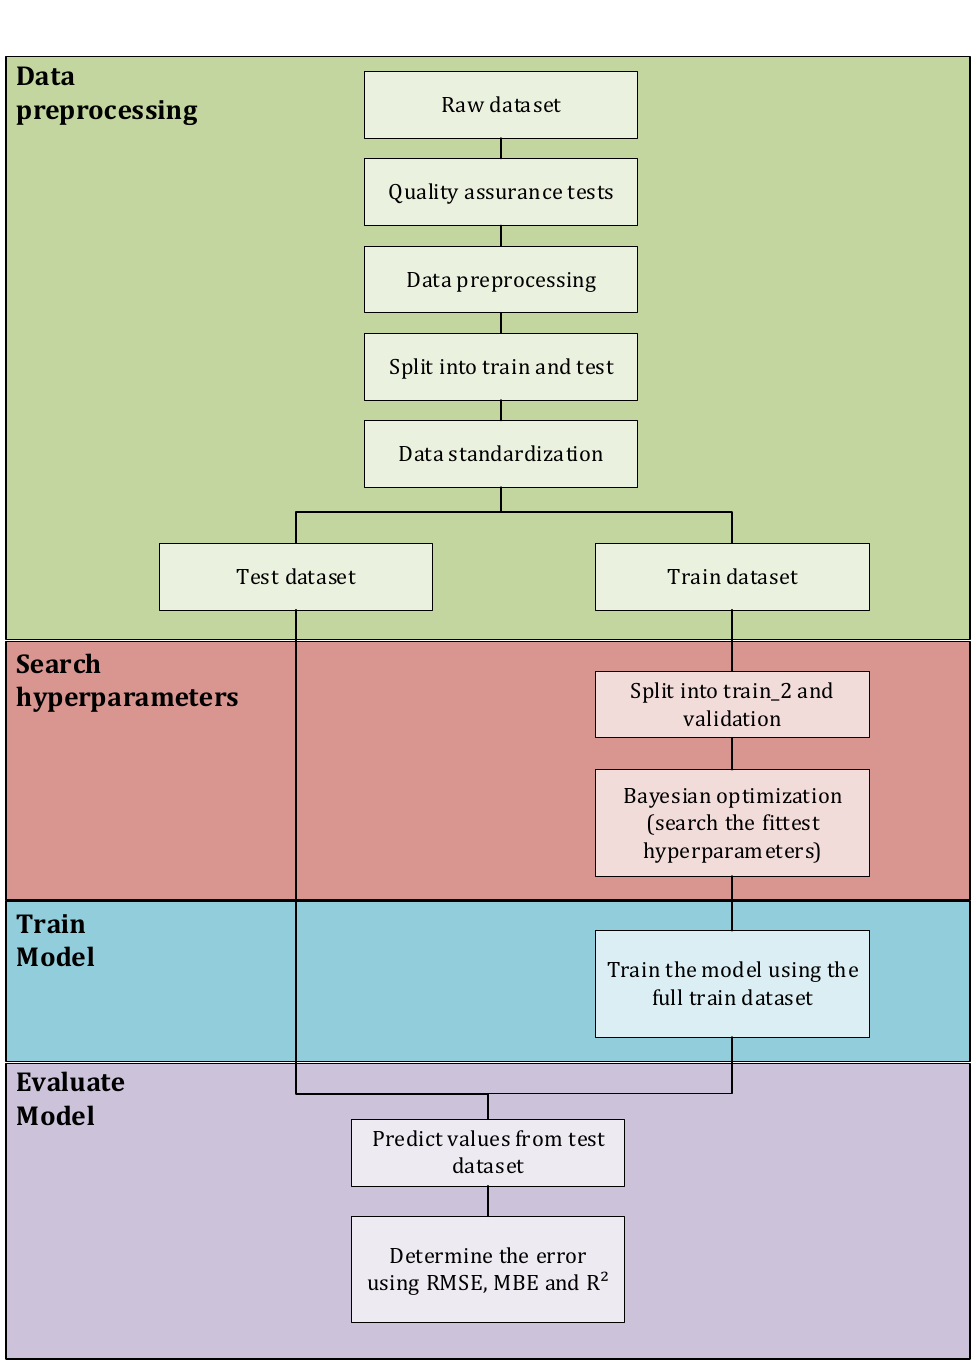
Figure 2 . Methodology flowchart . Figure 2. Methodology